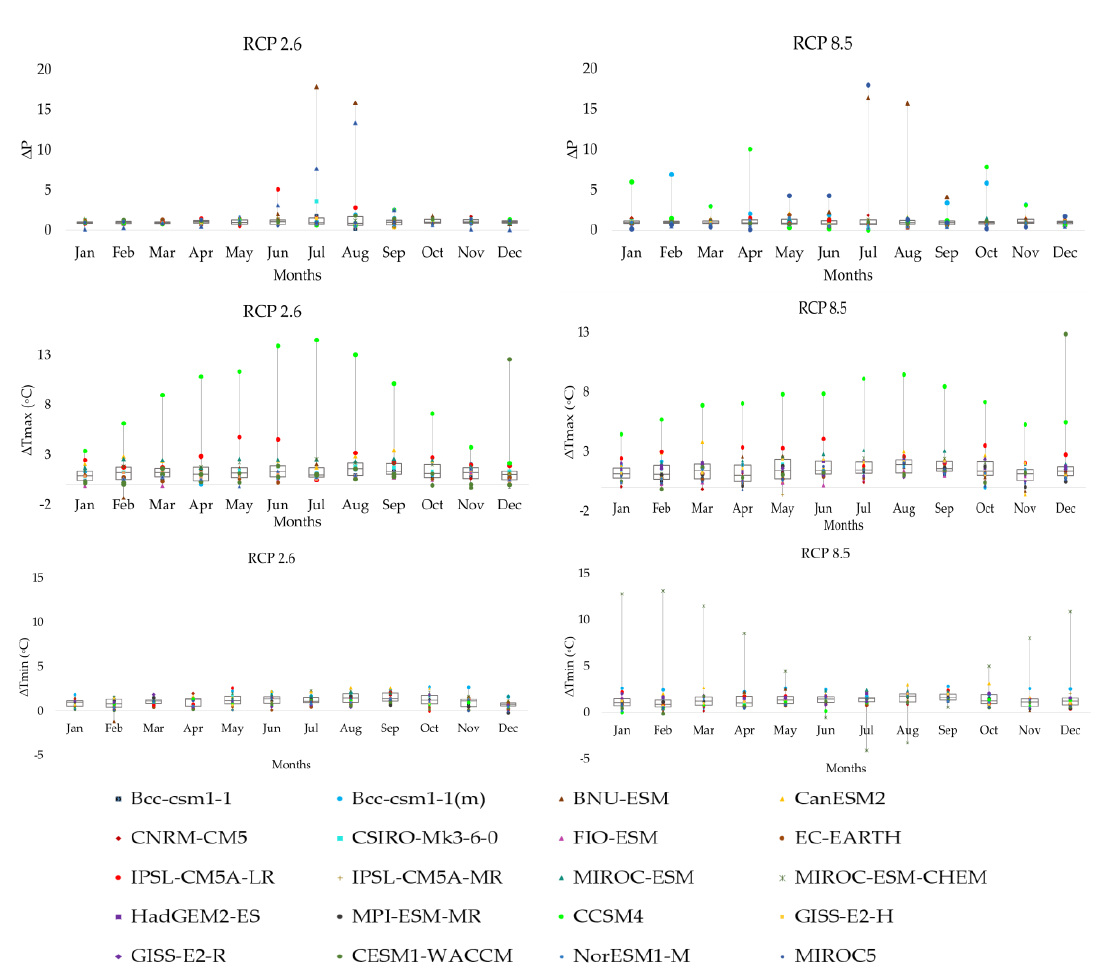
Figure 4. Variation of monthly mean precipitation and maximum and minimum temperature for twenty CMIP5 GCMs using RCP 2.6 and RCP 8.5. The lower end of the bar represents the 5th percentile, the upper end represents the 95th percentile, and the gray box represents the 50th percentile. Table 1. Median of precipitation and maximum and minimum temperature for RCP 2.6 and RCP 8.5 scenarios for each month.